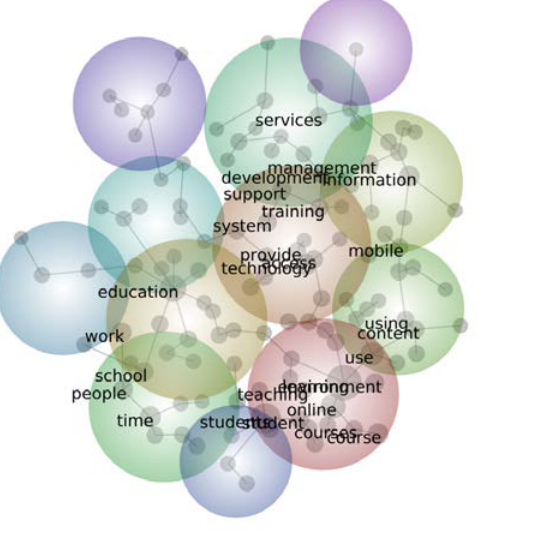
Figure 3 . An example of the concept map generated by Leximancer with the sample data.